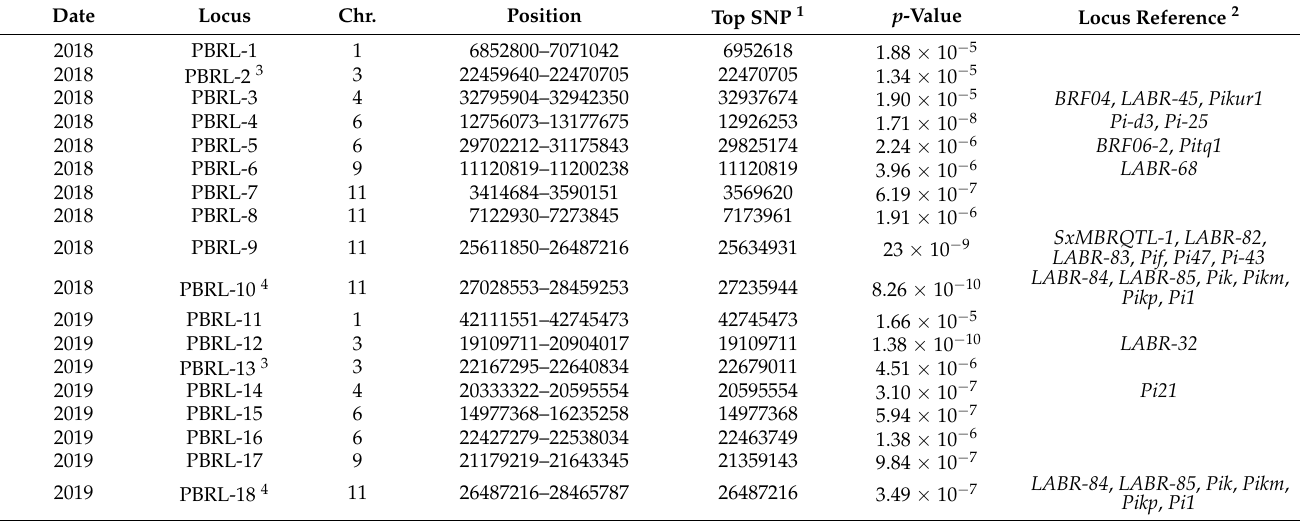
1 Within the detection site, the position of the peak SNP on the chromosome (bp). 2 Reported genes or QTLs in the same or overlapping intervals. 3,4 Same or largely overlapping genetic regions identified in 2018 and